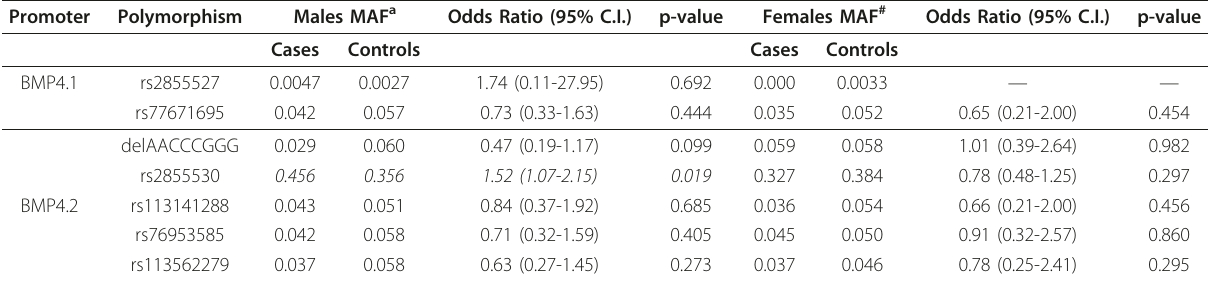
Table 2 Allelic association between BMP4.1 and BMP4.2 polymorphisms and NSCLP subdivided by gender.